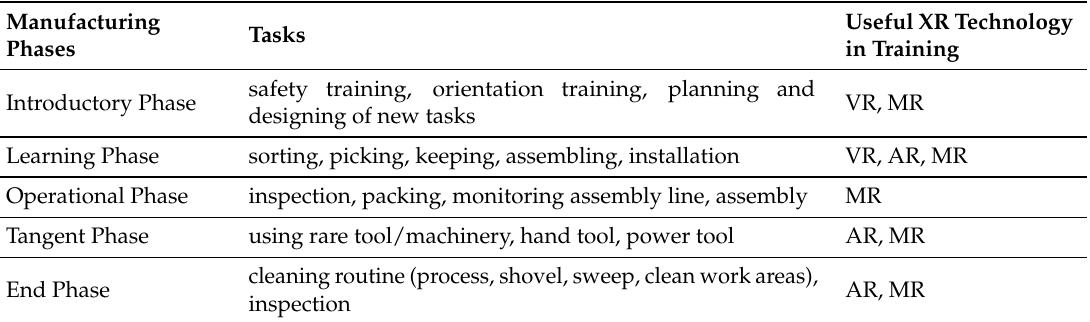
Table 2. Manufacturing phases and when to use which XR